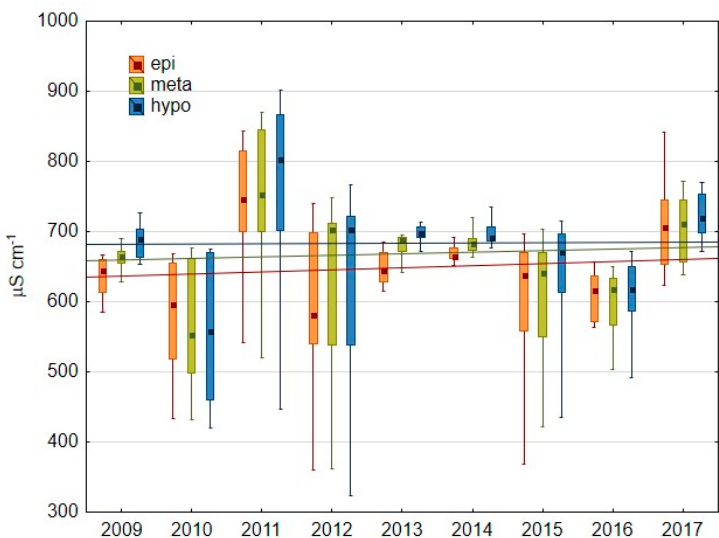
Figure 5. Box plot with min-max of conductivity in selected water layers representing epilimnion, metalimnion and hypolimnion at both stations. The lines indicate trendlines for each layer.